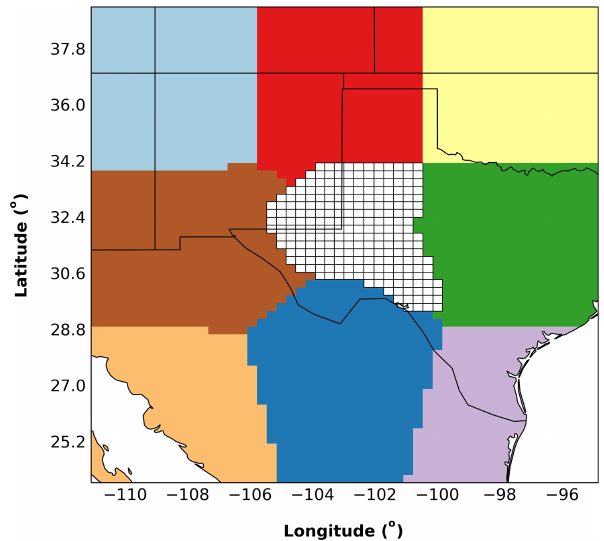
Figure 1. Example of an IMI state vector for inferring methane emissions from TROPOMI observations. Here the region of interest is the US Permian Basin in Texas and New Mexico (grid with white background), comprising 235 grid elements at 0.25 ◦ × 0.3125 ◦ res- olution generated from a shapefile. The inversion domain also in- cludes the areas in color bordering the region of interest, represent- ing eight buffer elements added to the state vector to correct errors in boundary conditions (see Sect.